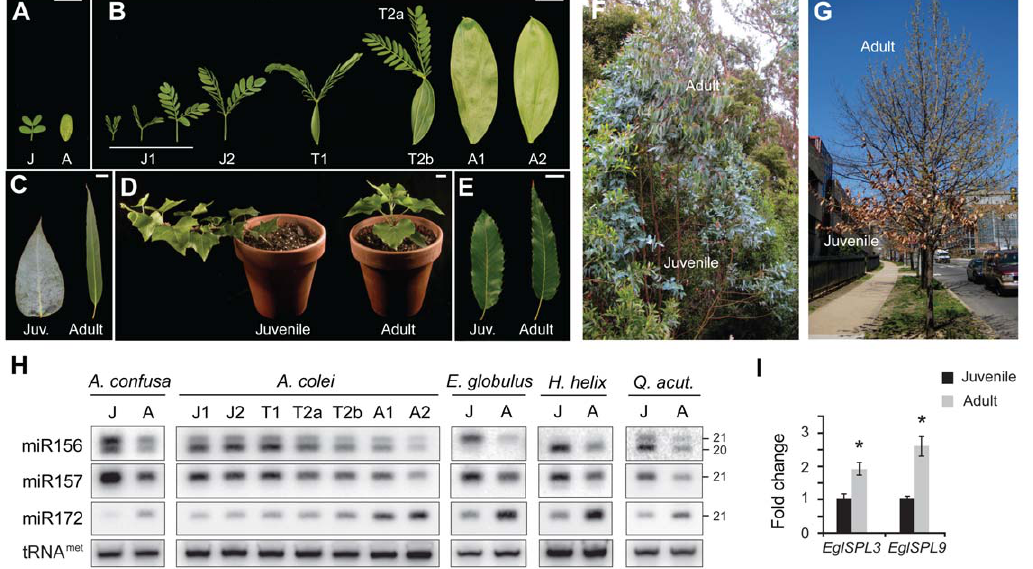
Figure 1. The expression of miR156 and its targets is correlated with vegetative phase change in woody plants. (A) Morphology of first two leaves of A. confusa . (B) Morphology of the first 8 leaves of A. colei . J=juvenile, T=transition, A=adult. (C) Juvenile and adult leaves from a single tree of E. globulus . (D) Juvenile and adult clones of H. helix (English ivy). (E) Juvenile and adult leaves of Q. acutissima . Scale bars indicate 2 cm. (F) One of the E. globulus trees from which the leaves used for expression analysis were harvested. (G) Q. acutissima tree from which the leaves used for expression analysis were harvested. (H) Blots of small RNA isolated from the leaves shown in Figure 1A–1E, hybridized with probes for miR156, miR157 and miR172; tRNA met was used as a loading control. The H. helix blot represents RNA from shoot apices with leaves 1 cm or less in size. (I) qRT-PCR analyses of the expression of EglSPL3 and EglSPL9 in fully expanded juvenile and adult leaves of E. globulus . Expression was normalized to EglElF4 , and then to the average expression in juvenile leaves. Shown are the averages of three technical replicates for samples from three trees (3 technical replicates 6 3 trees=9 replicates per sample), 6 s. e. m. Asterix=significantly different from juvenile, p , 0.01, Student’s t test.